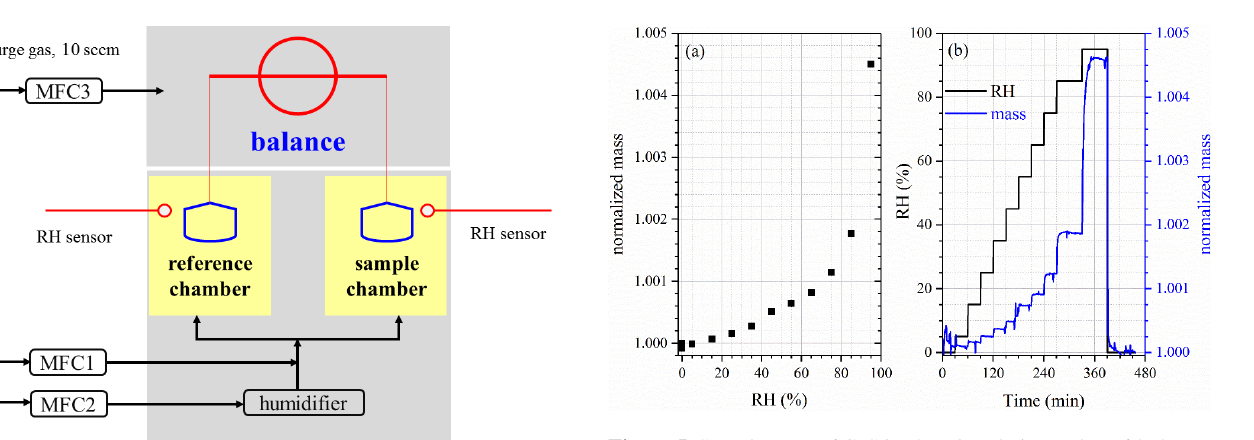
Figure 5. Sample mass of CaSO 4 · 2H 2 O (relative to that of 0% RH) as a function of RH at 25 ◦ C, measured using a vapor sorption an- alyzer. (a) Change in sample mass with RH up to 95%; (b) change in sample mass and RH with experimental time. Reprint with per- mission by Gu et al.